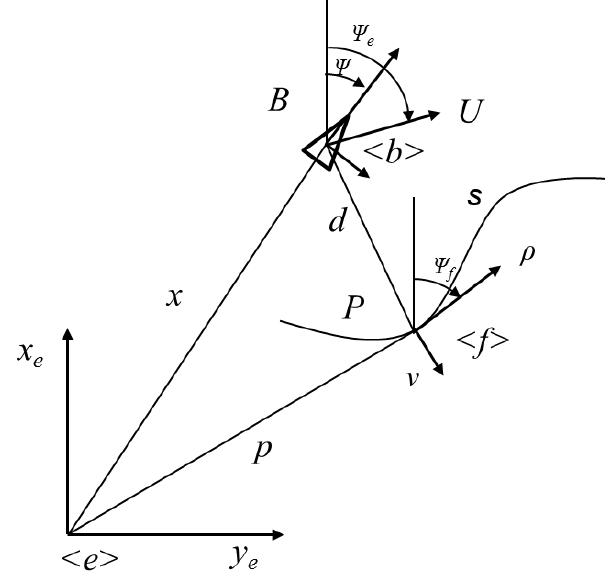
Figure 11. Frame definitions for path following algorithm based on a VT